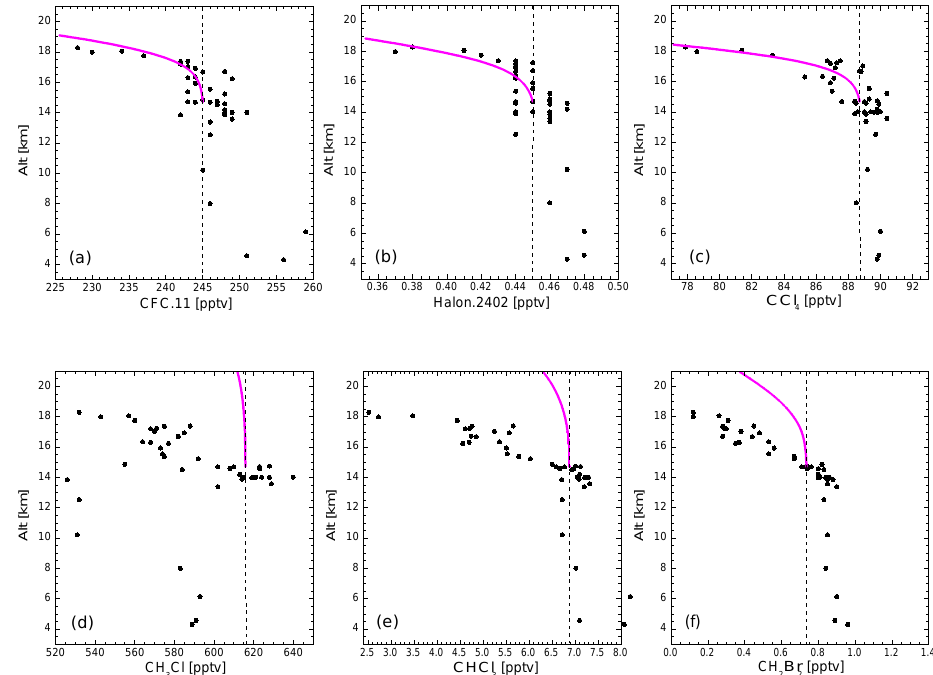
Fig. 4. Vertical distributions of (a) CFC-11, (b) Halon-2402, (c) CCl 4 , (d) CH 3 Cl, (e) CHCl 3 , and (f) CH 2 Br 2 . Plotted are individual data points (solid circles) measured by WAS on 5 August and the 1-D model results using photolysis rates alone as photochemical input (pink solid lines). Note that all calculations are based on the transport rates determined by CO 2